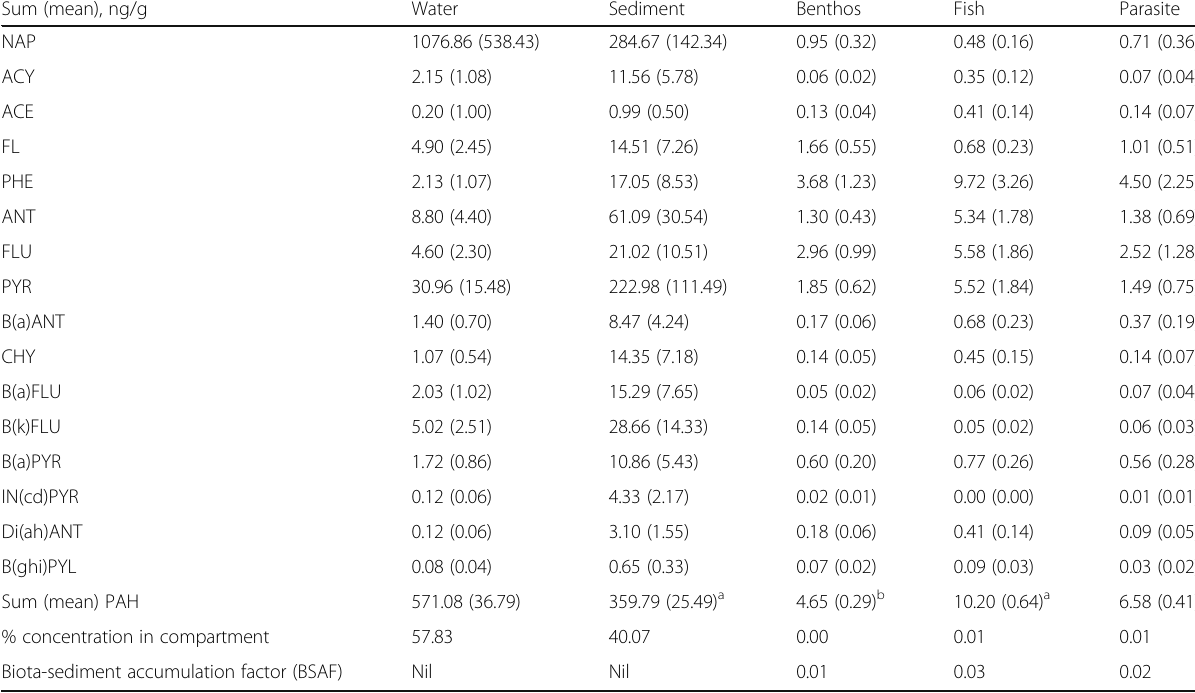
Table 5 Distribution in concentrations of PAH residues in compartments in Ibasa creek, Snake Island, Lagos Sum (mean), ng/g